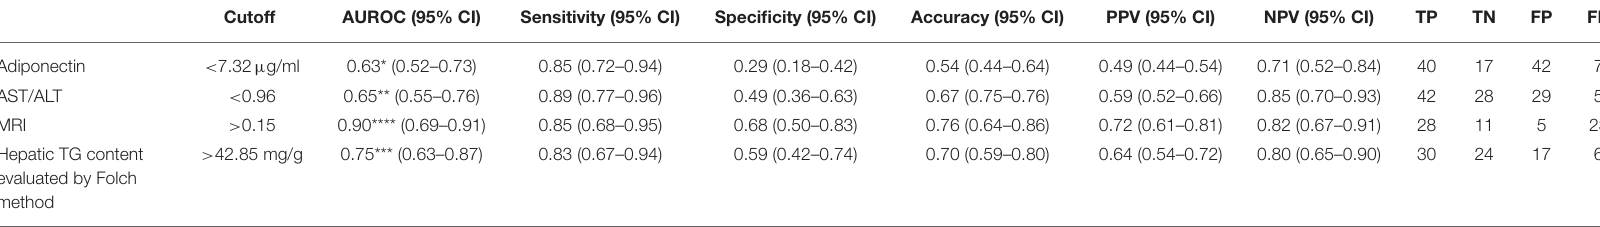
TABLE 3 | Performance of serum adiponectin in the differential diagnosis of NAFL vs. NASH in patients homozygous for the wild-type allele CC in the PNPLA3 rs738409 polymorphism. Cutoff AUROC (95% CI) Sensitivity (95% CI) Specificity (95% CI)